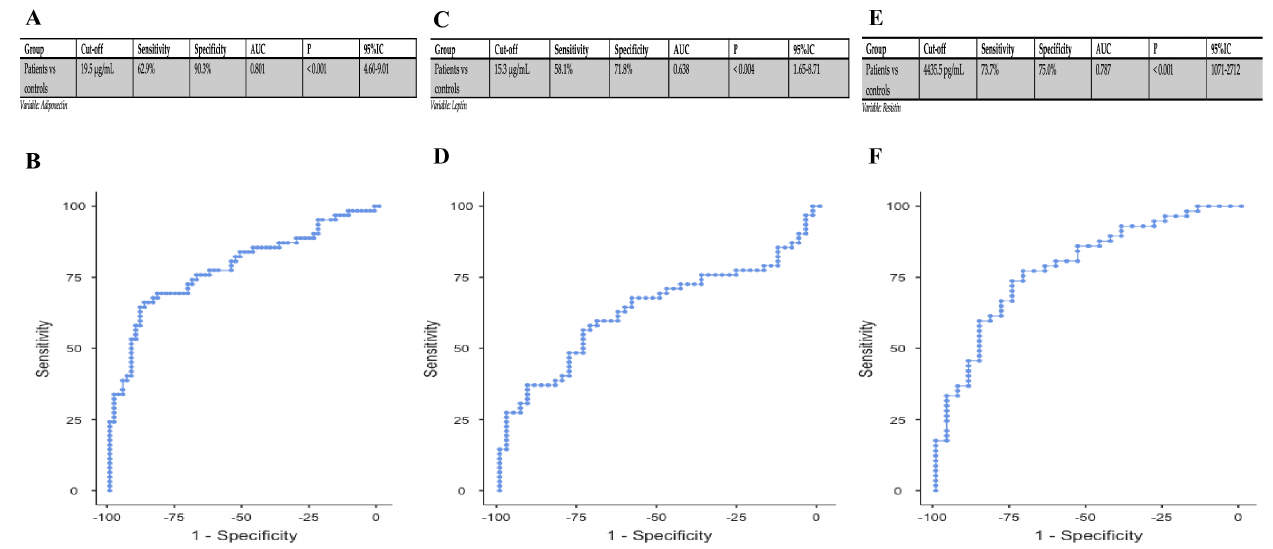
Figure 2. ROC curves for COVID-19 versus control of adiponectin ( A , B ), leptin ( C , D ) and resistin ( E , F ).